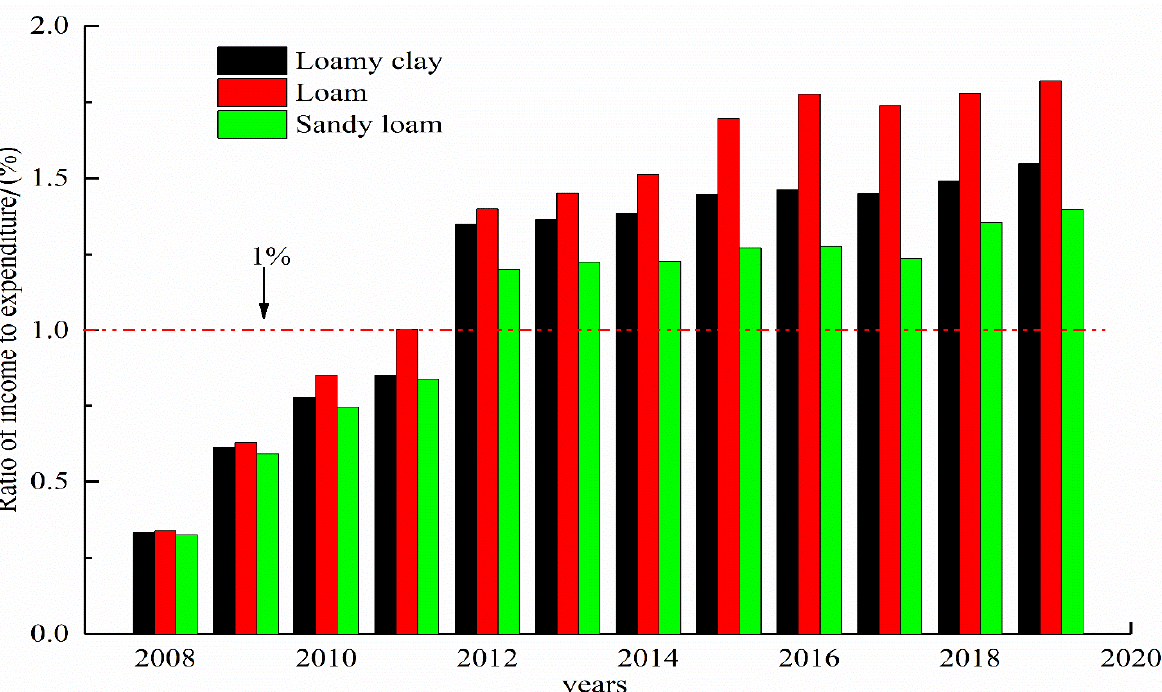
Figure 7. The income and expenditure ratio of different soil quality.